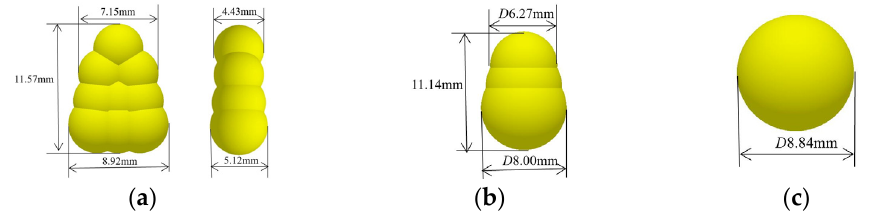
Figure 4. The discrete element model of maize seeds. ( a ) Horse tooth. ( b ) Spherical cone. ( c ) Spher- ical.